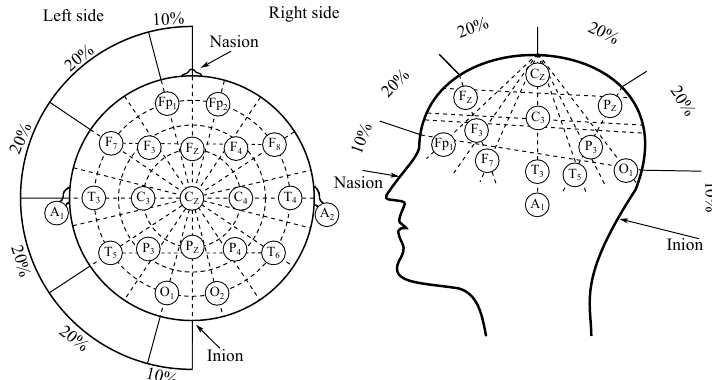
Figure 1. The EEG electrodes placement system “10–20”.